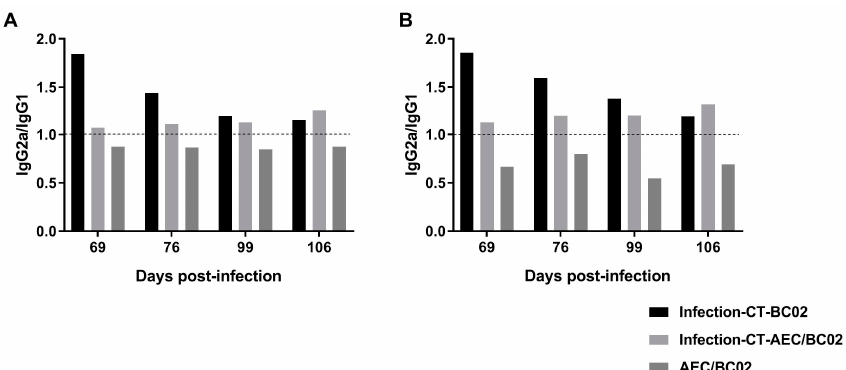
Figure 6. The immunological types of Mtb latently infected and normal mice induced by AEC/BC02. ( A ) The ratio of Ag85b-specific IgG2a/IgG1. ( B ) The ratio of EC-specific IgG2a/IgG1. IgG2a/IgG1 > 1 indicates Th1-type bias, whereas IgG2a/IgG1 < 1 indicates Th2-type bias.